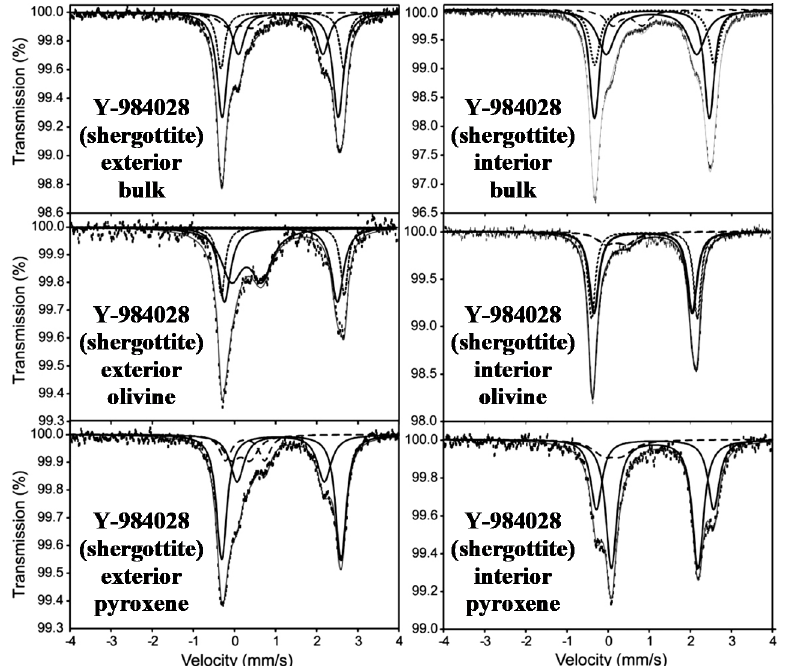
Figure 14. Room temperature Mössbauer spectra of the exterior and interior chips (bulk material) and olivine and pyroxene separates from the Y-984028 lherzolitic shergottite. Indicated spectral components are the results of the fits. Adapted from [36].